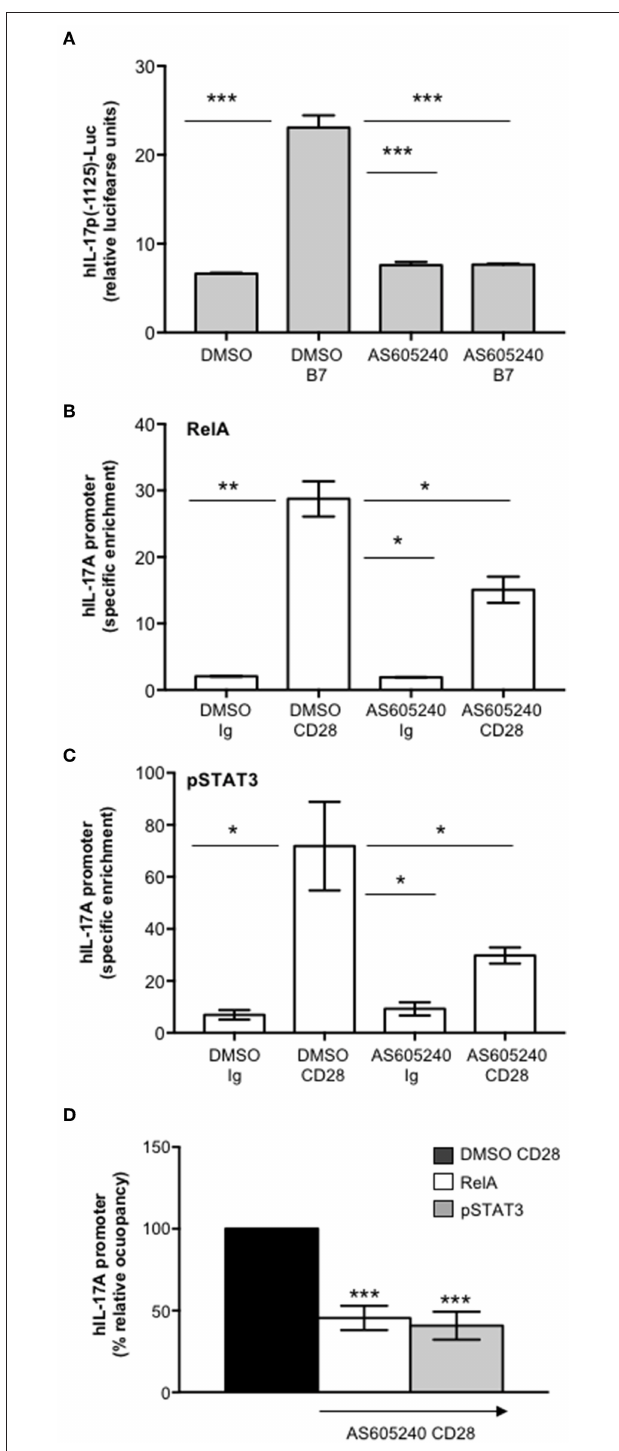
FIGURE 8 | Inhibition of class 1 PI3K activity impairs CD28-induced recruitment of pSTAT3 and RelA on IL-17A promoter. (A) hIL-17p(-1125)-luciferase activity of Jurkat cells treated with DMSO, as vehicle control, or 10 µ M AS605240 and stimulated with Dap/B7 cells (B7). Fold inductions over DMSO un-stimulated cells were calculated. The results